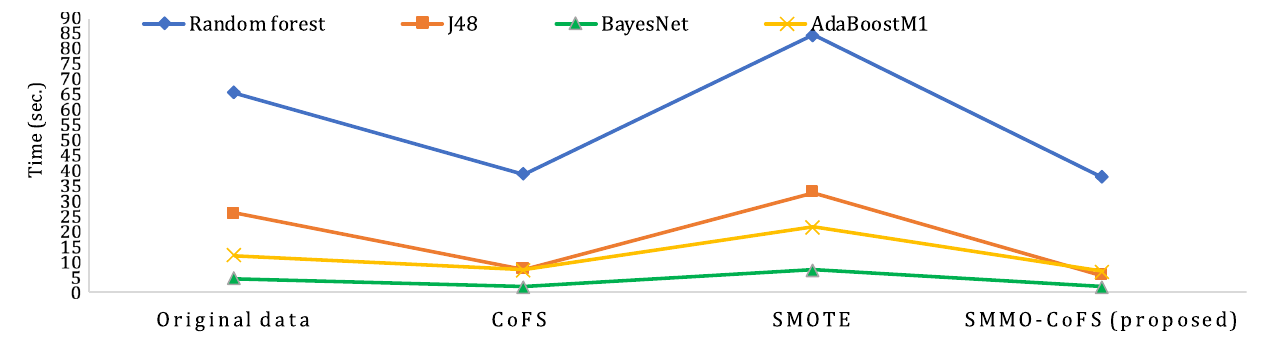
Bold values indicate the best results obtained for